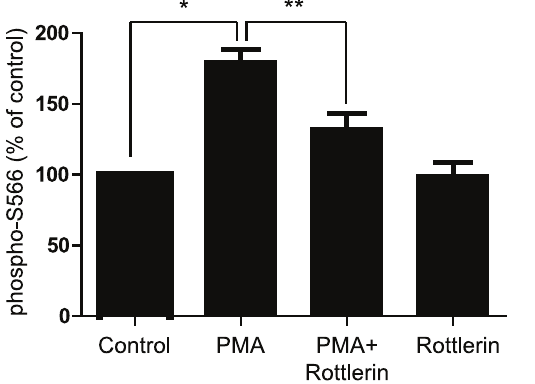
Figure 2. Rottlerin inhibits PMA-dependent phosphorylation of Ser566 in B56 d . N2a cells expressing FLAG-B56 d were pretreated without or with rottlerin (5 m M) for 30 min as indicated and then treated with DMSO (Control) or PMA (10 nM) for an additional 10 min. Phosphorylation of Ser566 and total B56 d was assayed as above. The bar graph shows quantification of immunoblot data (not shown) normalized in each experiment to control as means 6 s.e.m. (n=3). *, P , 0.001, **, P , 0.01 compared with vehicle-treated vector control by one-way ANOVA with Newman-Keuls multiple comparison test.